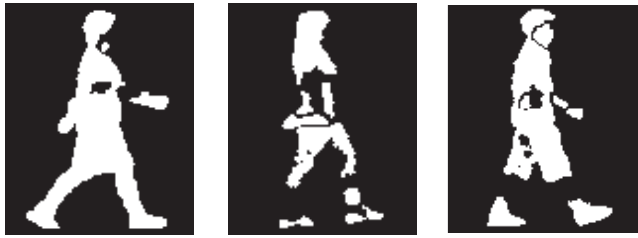
Figure 5. Examples of silhouette images of the CASIA-C dataset.